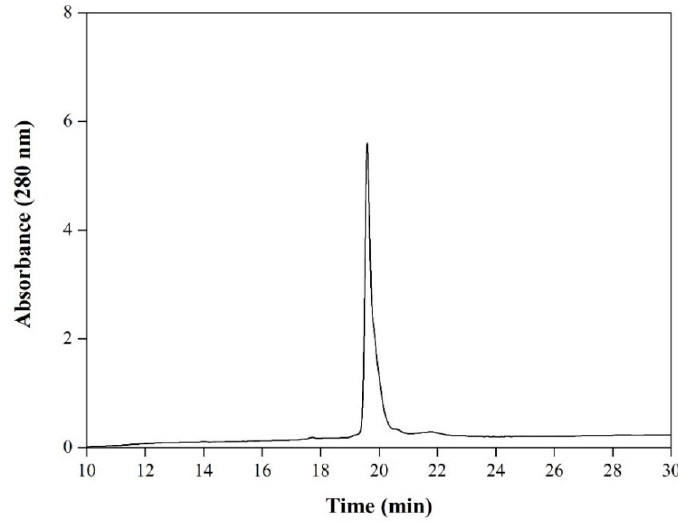
Figure 4. RP-HPLC analysis of rRBD purified by IMAC.